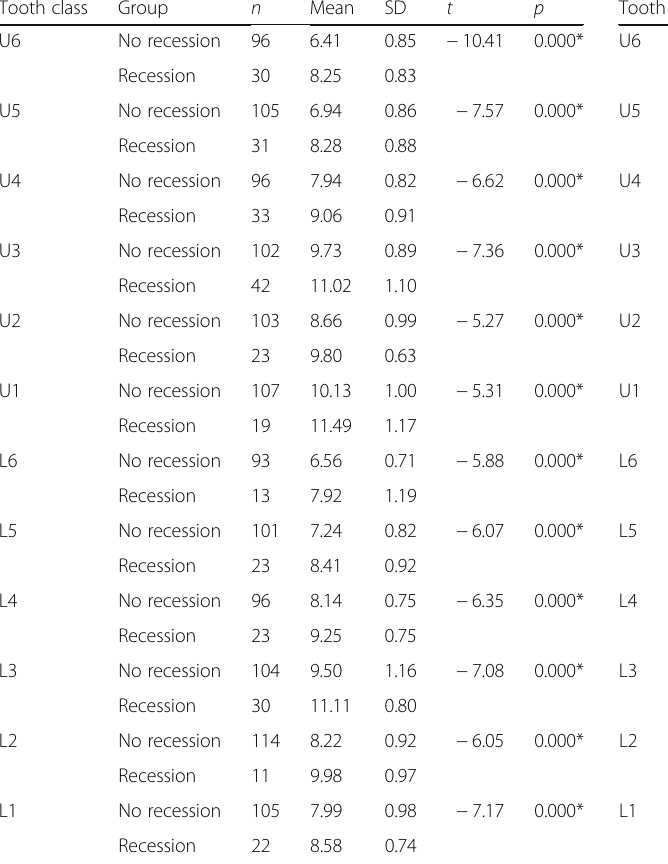
Table 3 Independent t -tests comparing the no recession to recession subgroups using the clinical crown height measure for the combined four groups